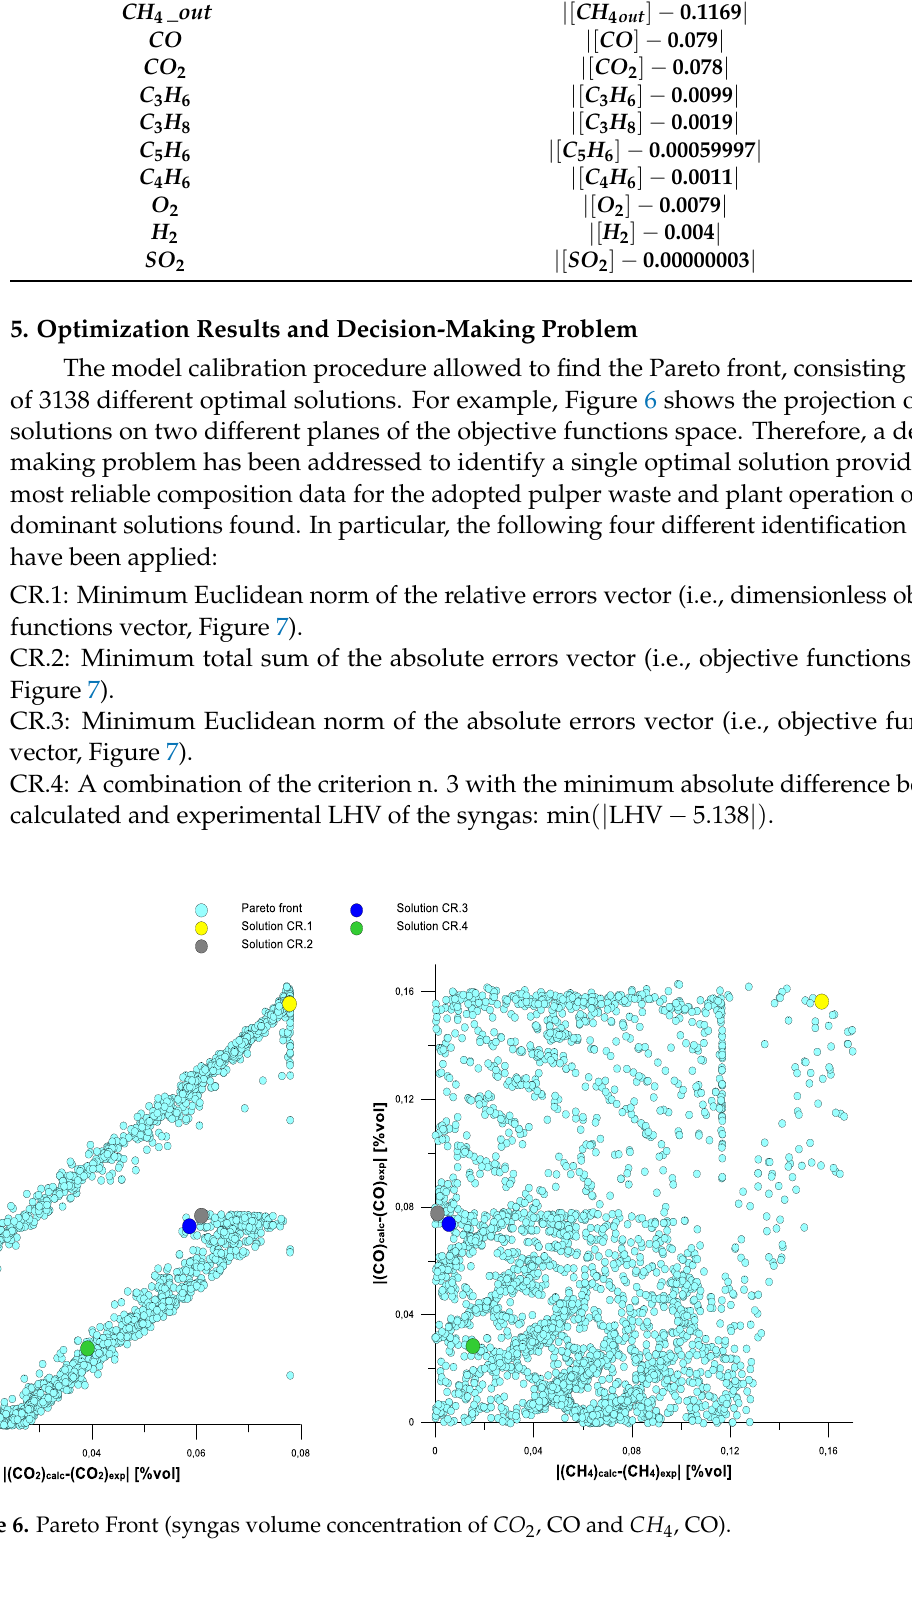
Figure 7. Example of application of CR.1, CR.2, and CR.3 adopted within the decision-making process. The application of these criteria led to the identification of four different optimal so- lutions, each of them characterized by specific values of decision variables (Table 7) and objective functions (namely syngas composition, Table 8). In the first and third case (CR.1 and CR.3), considering the respective axes origin as the single ideal optimal solution, the Pareto solution that is closest to axes origin is privileged (ID 409 and ID 1933, respec- tively). Criteria CR.2 and CR.4 enabled the identification of the solutions labeled ID 372 and ID 1205, respectively. In particular, the last solution is characterized by a LHV of 5.137MJ/kg, which almost corresponds to the experimental value.